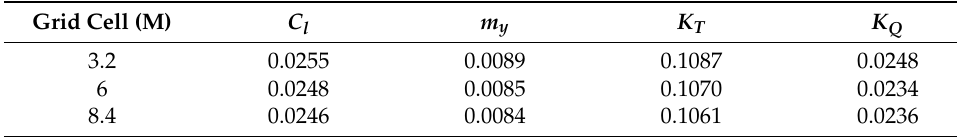
Table 4. Grid-independence